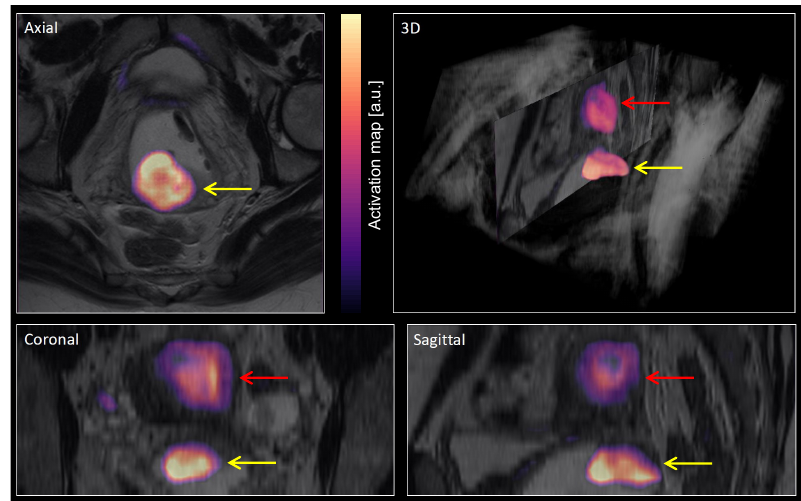
Figure 2. A visualization of the activation map (colored regions) from the DL (deep learning) segmentation superimposed on T2-weighted MRI (grayscale colormap) for three orthogonal planes and using 3D volume rendering. The activation map was later transformed with a sigmoid function and then thresholded, resulting in a binary prediction map. Two objects were identified in this patient: The object positioned in the uterine cervix (yellow arrows) had the largest mean activation value and was thus automatically selected to represent primary tumor. The object positioned in the uterine cavity/body (red arrows) had lower mean activation value and was thus